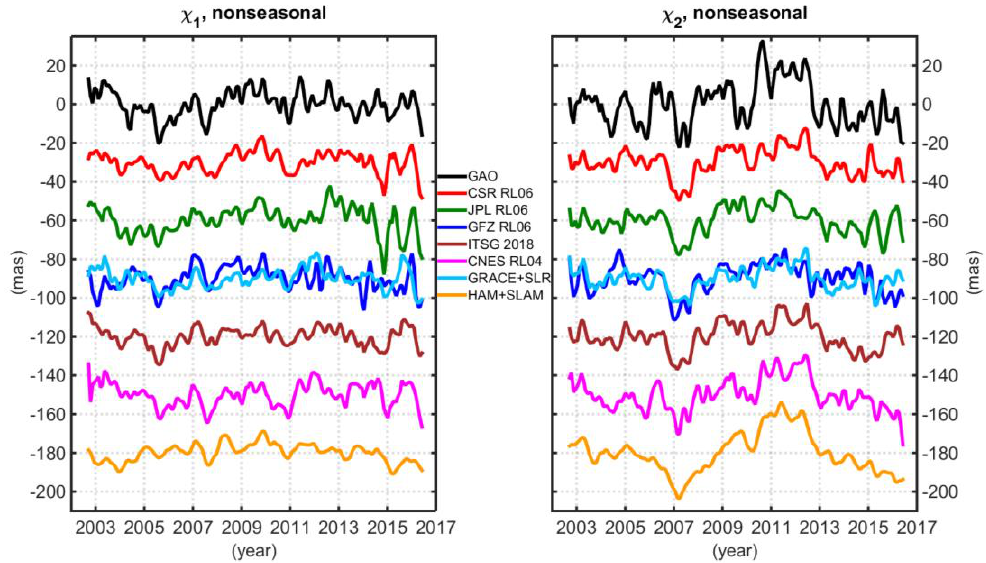
Figure 10. Non-seasonal changes of χ 1 and χ 2 components of GAO, GSMAM, GRACE + SLR, and HAM + SLAM. Table 5. Standard deviation of non-seasonal GSMAM, GAO, GRACE + SLR, and HAM + SLAM time series, correlation coefficients with GAO, and percentage of variance in GAO explained by GSMAM, GRACE + SLR, and HAM + SLAM. The critical value of the correlation coefficient for 38 independent points and a confidence level of 0.95 is equal to 0.27. A standard error of a difference between two correlation coefficients for 38 independent points is equal to 0.24. The highest values of correlations and relative explained variances are italicized.